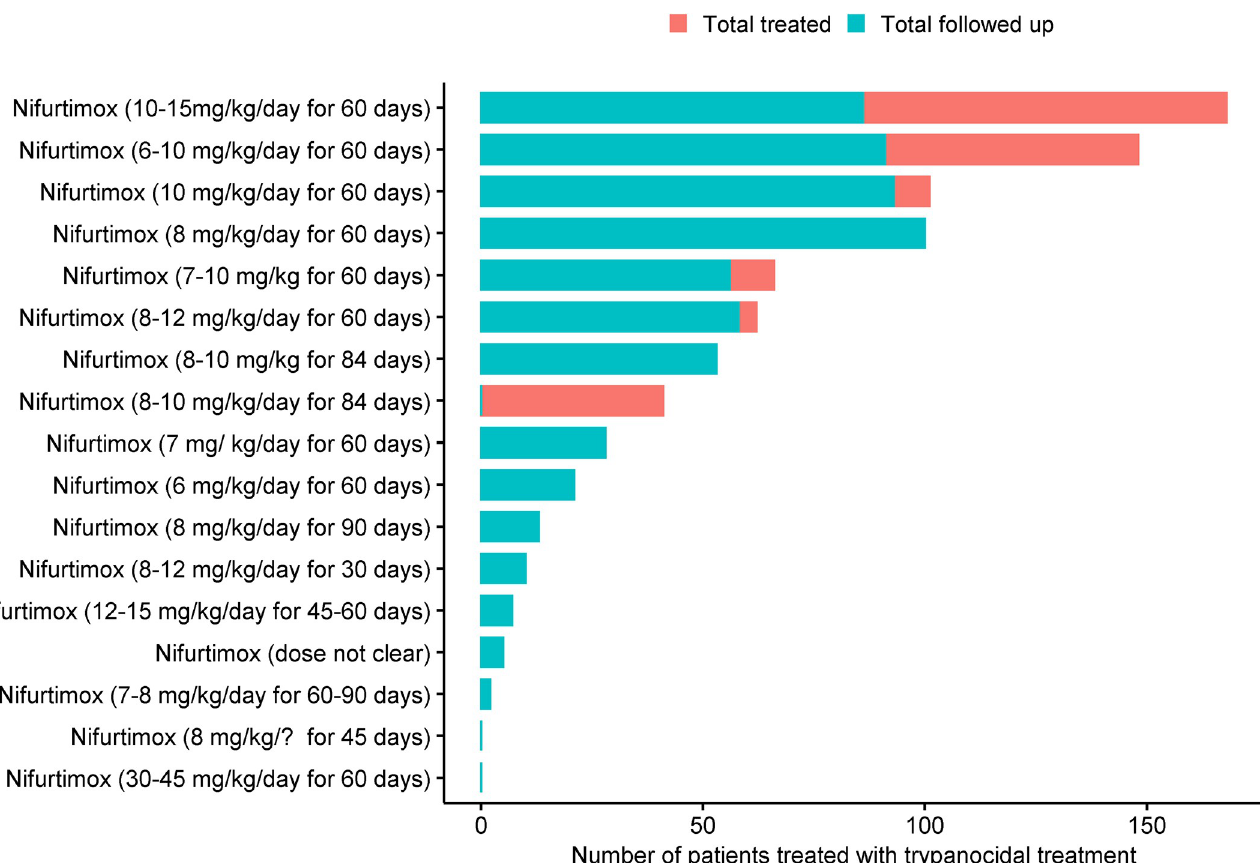
Fig 6. Body weight adjusted (mg/kg) drug dosage variability for